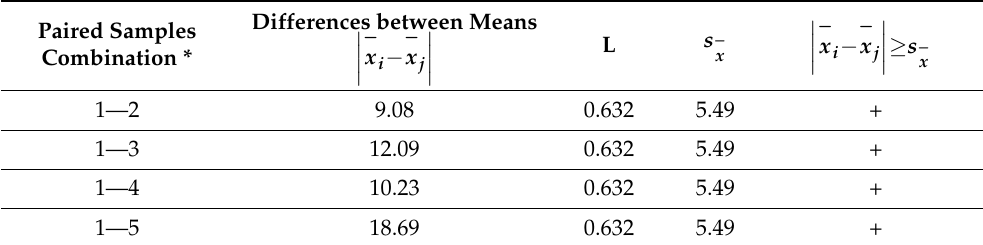
Table 5. Comparison of samples for significance of differences in mean flexural strength measure- ments by post-hoc Fisher LSD